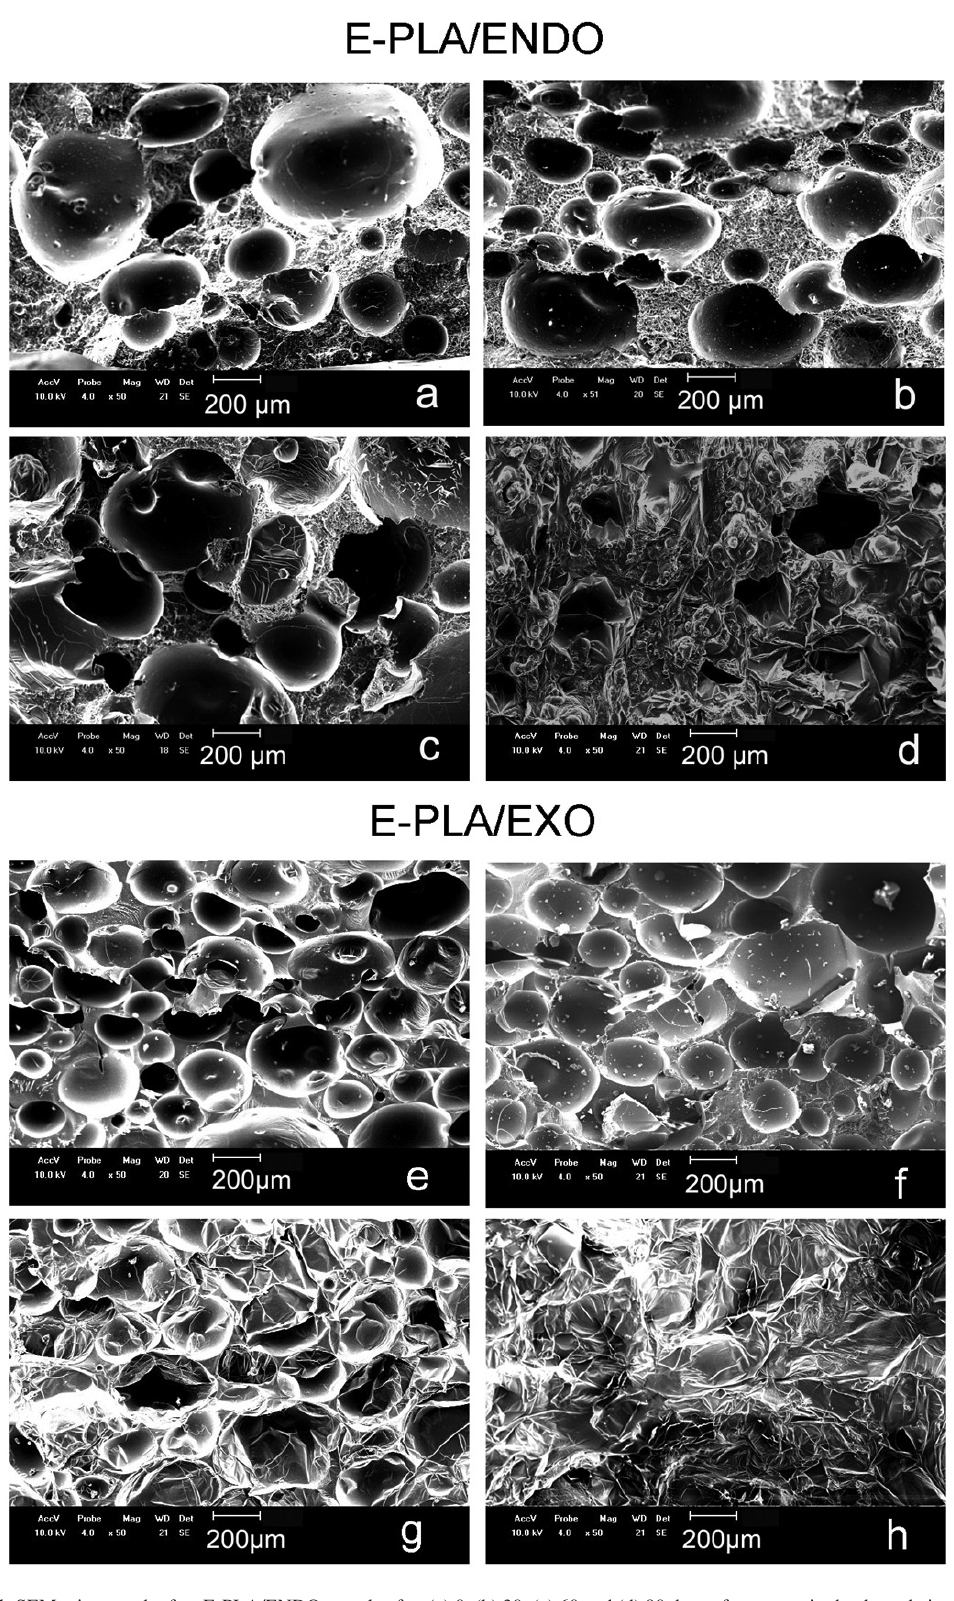
Figure 1. SEM micrograph of an E-PLA/ENDO sample after (a) 0, (b) 30, (c) 60 and (d) 90 days of exposure in the degradation test and E-PLA/EXO after (e) 0, (f) 30, (g) 60 and (h) 90 days of exposure in the degradation